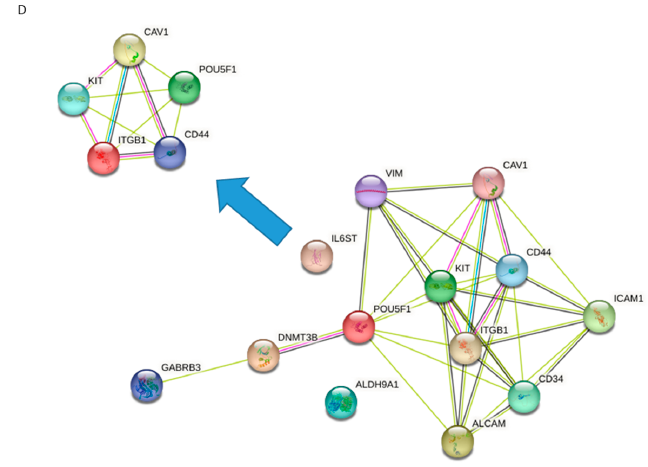
Figure 7. Identification of candidate shared stemness and chemoresistance therapeutic targets. ( A ) Summary of strategy to identify shared markers of stemness and MDR in ES preclinical models. ( B ) Stemness and MDR-associated genes increased in 3D spheroids and patient-derived ES-CSCs. The full and alternative gene names, the Ensembl gene abbreviation (Gene) and the data from which genes were identified (Source of the gene) are shown. The source of the gene is presented as 1 or 2, where 1 = target gene identified from transcriptome analysis of patient-derived ES-CSCs [17] and 2 = target gene identified by comparing transcriptome of SK-N-MC and TTC 466 cells grown in 3D and 2D (Figures 3 and 4). ( C ) Pipeline to identify candidate drugs based on 21 stemness and chemoresistance genes. Green ovals = drug-repurposing data sources, pink ovals = public data sources, blue squares = number of targets or drugs at each step. ( D ) Predicted interaction between the 13 shared stemness and chemoresistance genes (excluding p-glycoprotein and MRP1) that have corresponding candidate drugs using STRING [30]. Five of the genes are known to bind and regulate vital biological processes, and could be candidate prognostic biomarkers and/or therapeutic targets in ES. Pink lines = known interaction that has been experimentally determined, extracted from BIND, DIP, GRID, HPRD, IntAct, MINT and PID databases. Blue lines = known interaction based on data from curated databases Biocarta, BioCyc, GO, KEGG and Reactome. Grey lines = proteins reported to be co-expressed. Green lines = interactions identified by text mining. Filled nodes = 3D structure known or predicted. Coloured nodes = first shell of interacting proteins. White nodes = second shell of interacting proteins. Parental cells = patient-derived bulk population of ES cells from which the ES-CSCs were derived [14].